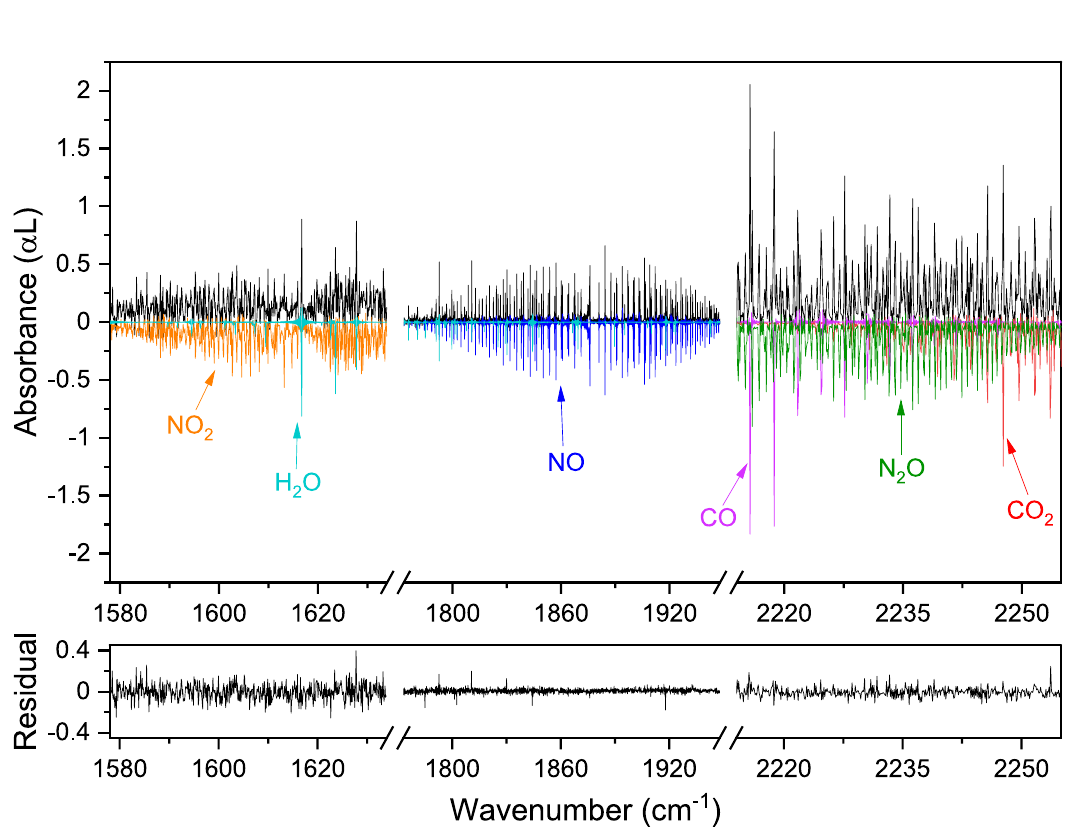
Figure 5. Measured spectrum (in black, 0.1 cm −1 spectral resolution, 16.5 mbar pressure, ~ 16 min) of reaction products of a 50% CO 2 /50% N 2 discharge and the fitted modelled spectra (in colors, inverted) based on the HITRAN database parameters and Voigt profiles convolved with a sinc function. The residual of the fit is shown in the lower